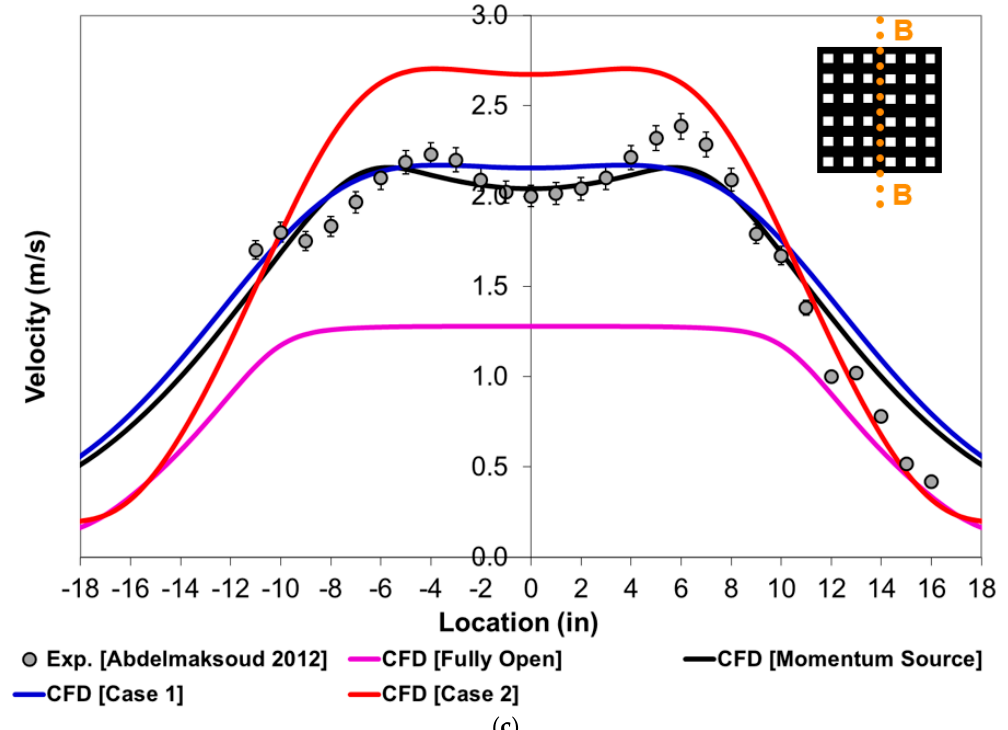
Figure 7. ( a ) Tile flow distortion effect on velocity profiles at 1 ft height along line B ‐ B. ( b ) Tile flow distortion effect on velocity profiles at 2 ft height along line B ‐ B. ( c ) Tile flow distortion effect on velocity profiles at 3 ft height along line B ‐ B.